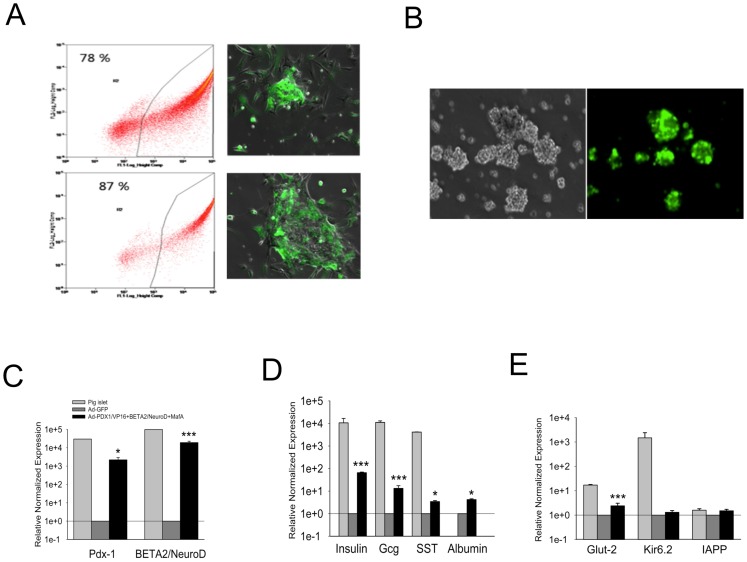
Viral transduction efficiency determined via FACS and relative gene expression determined via quantitative real-time PCR.(A) Various viral titers were tested using green fluorescent protein (GFP) as a reporter gene. Sampling was performed at 72 h after the transduction of Ad-GFP. The obtained transduction efficiency was 78% using a multiplicity of infection (MOI) of 50 after 16 h (upper) and 87% at an MOI of 100 (bottom). (B) Monolayer cells spontaneously formed clusters on low-attachment culture dishes at 24 h after transduction. Most of the clusters expressed GFP well at 72 h after transduction (C–E) qRT-PCR analysis in transduced cells. Sampling was performed during final step of differentiation. Ct values were normalized to GAPDH gene expression within the same cDNA sample. The results are presented as the fold increase based on GAPDH gene expression. All primers were designed based on the pig-aligned sequence from NCBI. The presenteddata are the means of six independent experiments. The meansand standard error values are presented. *P<0.05; **P<0.01; ***P<0.005;Error bars, S.E.